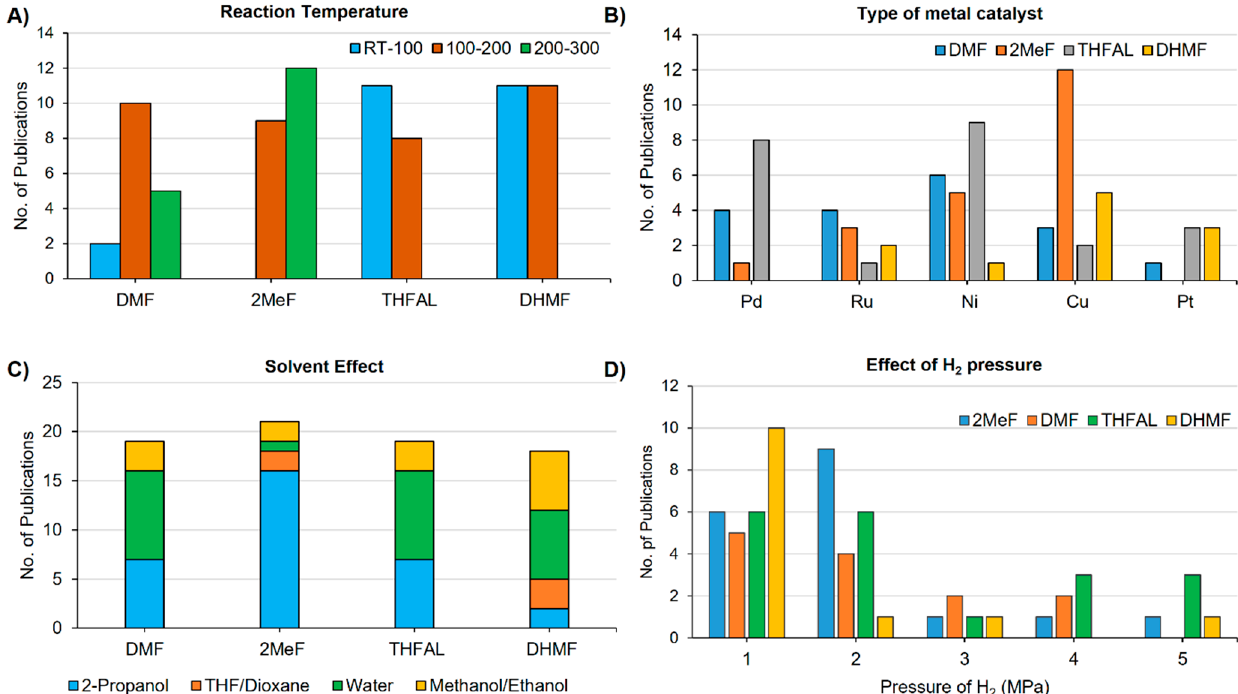
Figure 1. Graphical plots of the number of journal publications on DMF, 2MeF, THFAL, and DHMF against varied ( A ) reaction temperature, ( B ) type of metal catalyst, ( C ) solvent, and ( D ) hydrogen pressure. (Data taken from Tables 1–4).